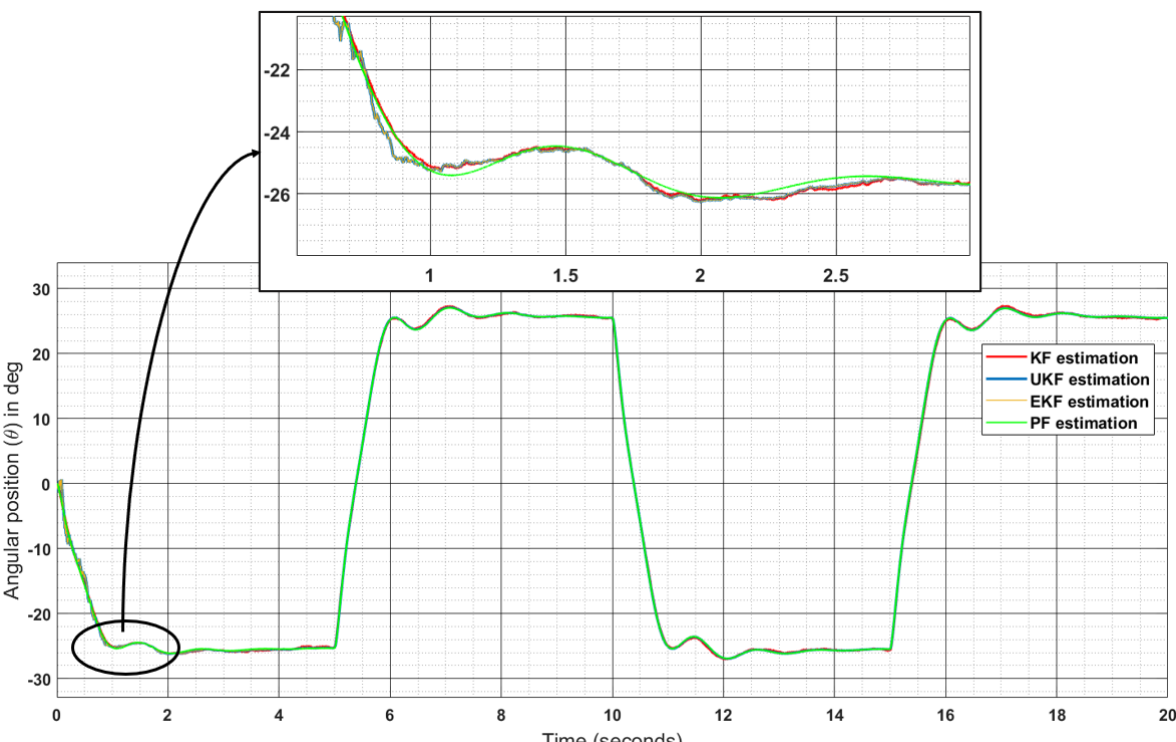
Figure 14. Comparison of filter responses with fractional order control for Joint